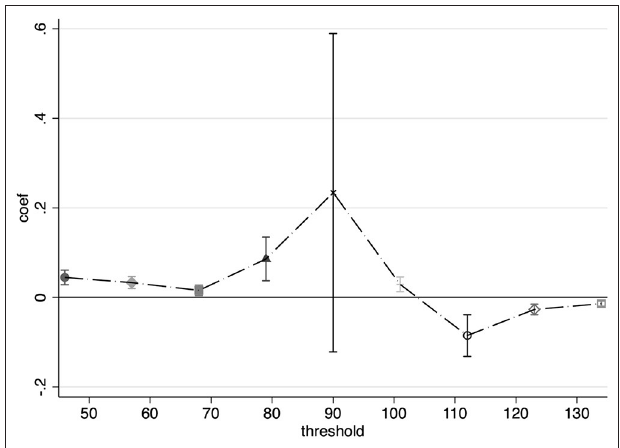
FIGURE 4 | Non-linearity of PM 2.5